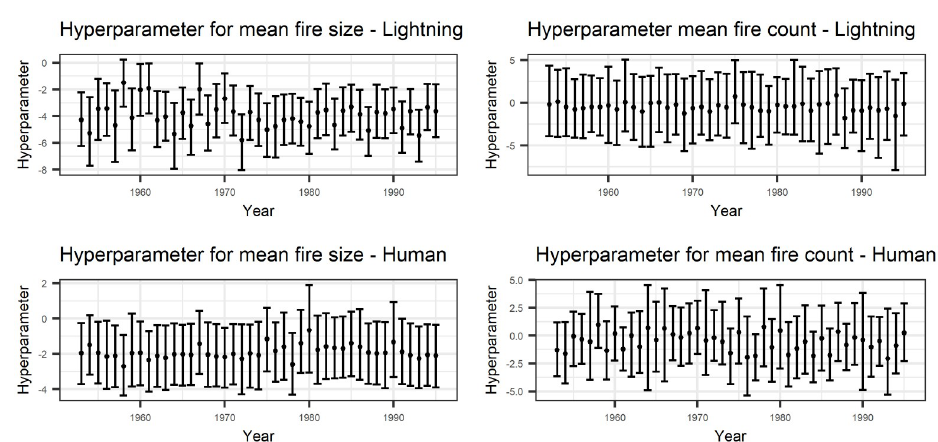
Fig 5. Hyperparameters for the mean of the size and count. By the construction of the model, the regional parameters are deviations from these values, with the hyperparameters representing the mean over all regions. All of these parameters are on the log scale.